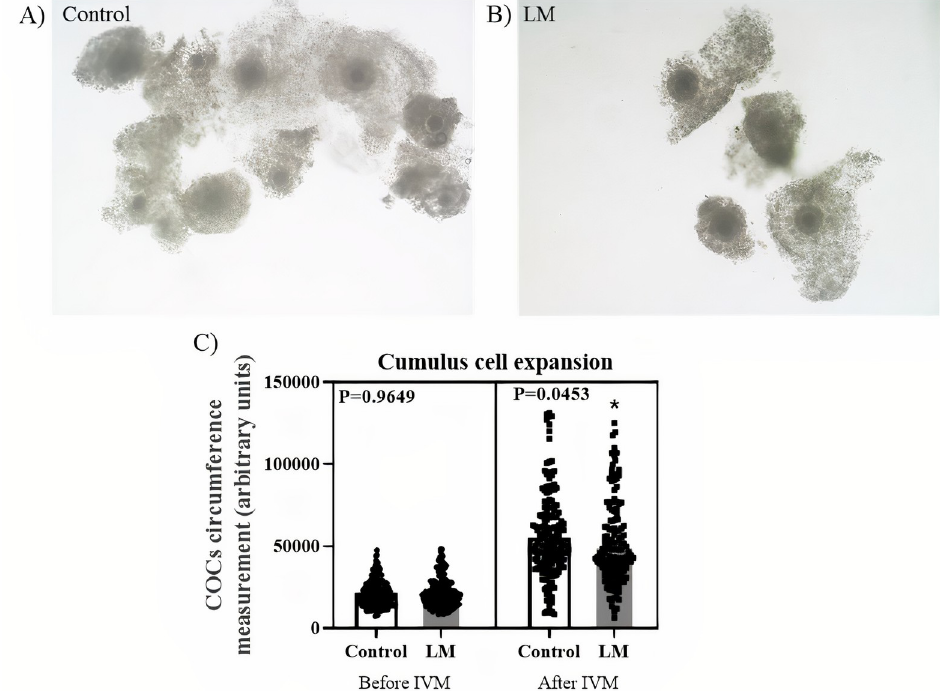
Fig 3. Cumulus cells expansion analysis. A) Cumulus-oocyte-complexes after IMV in control and B) LM systems. C) Cumulus cells expansion before IVM in control (n = 180) or LM system (n = 180), and after IVM in control (n = 172) or LM (n = 154) systems. Circumference of COCs were measured using ImageJ software. Analysis were performed using Wilcoxon test and asterisk represent statistical difference, considered when P <